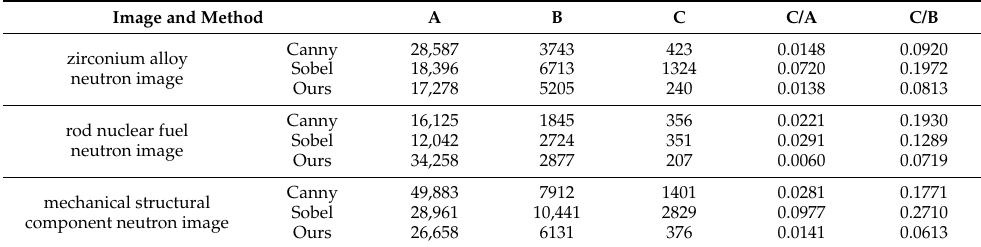
Table 4. Result of edge evaluation method based on connection component for three different materials neutron